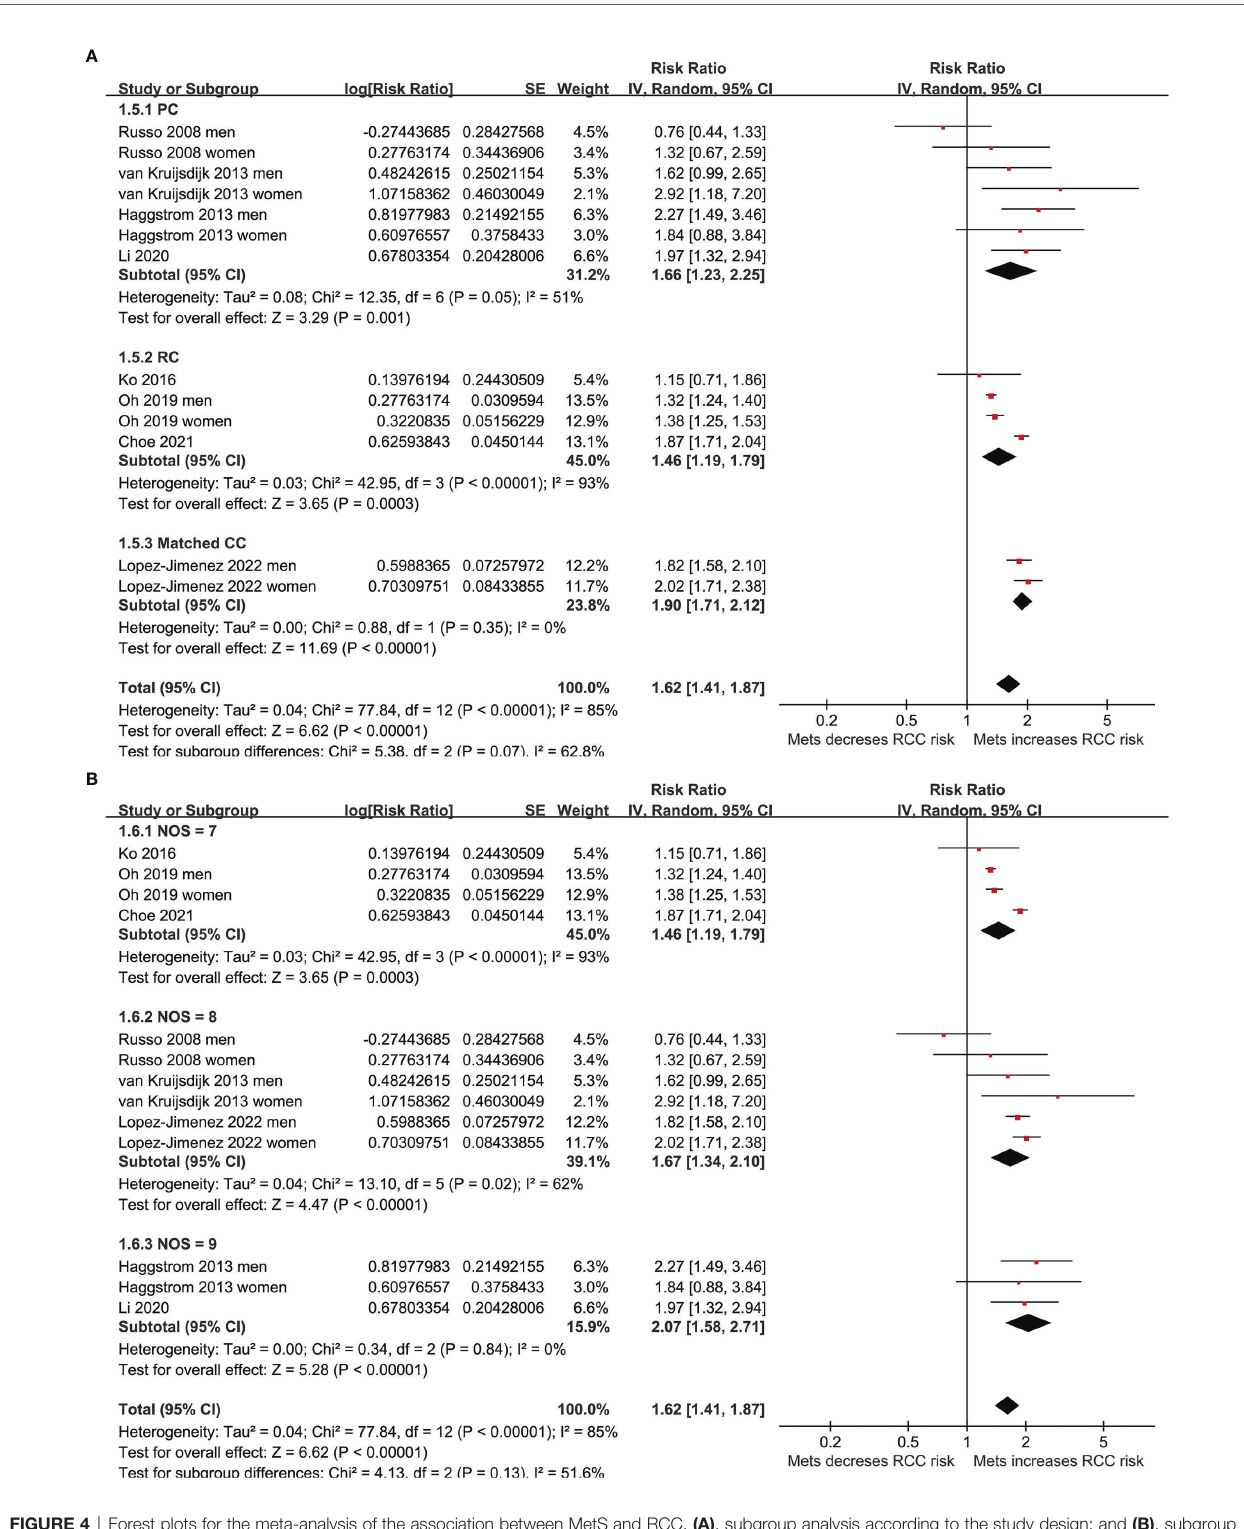
FIGURE 4 | Forest plots for the meta-analysis of the association between MetS and RCC. (A) , subgroup analysis according to the study design; and (B) , subgroup analysis according to the study quality